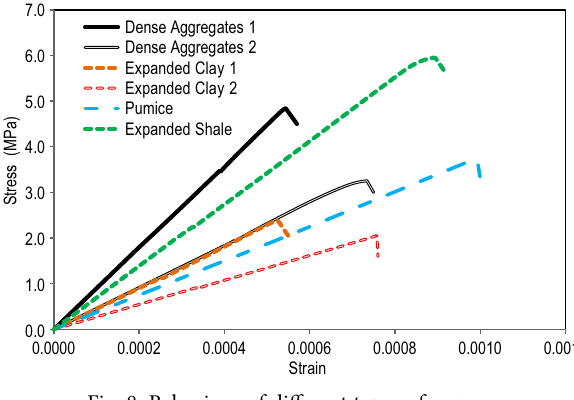
Fig. 8. Behaviour of different types of masonry systems until collapse